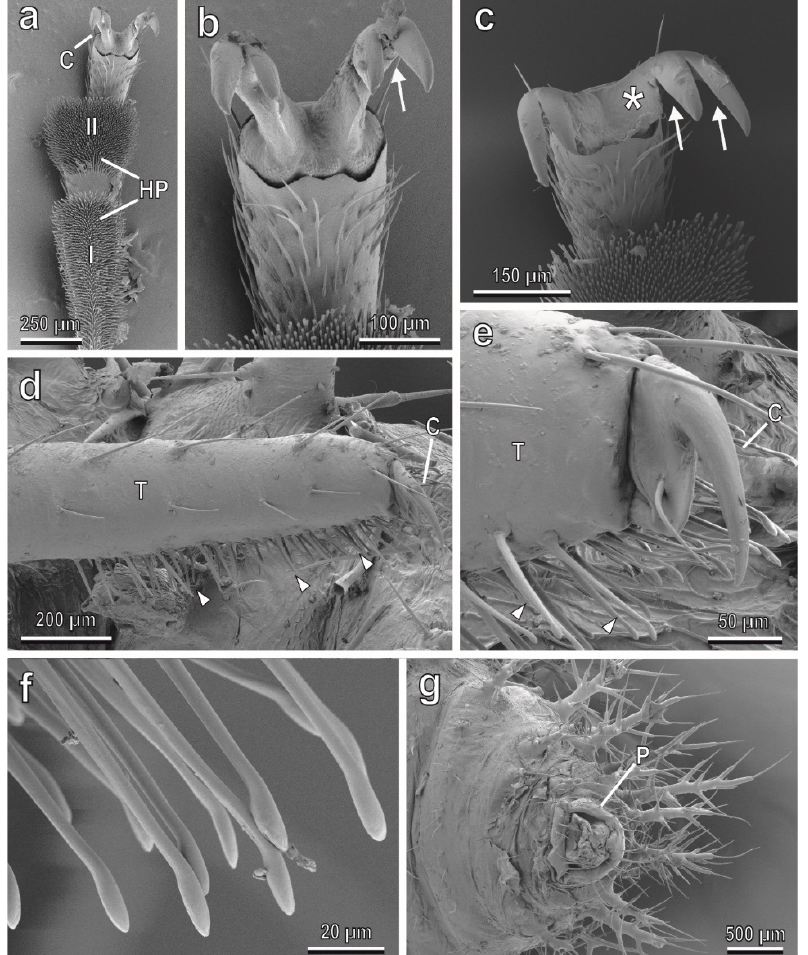
Figure 1. Tarsi of the female ( a – c ) and of the larva ( d – g ) of Chnootriba elaterii , cryo-SEM. ( a ) Hairy pads (HP) covered with numerous tenent setae located on the ventral side of the first (I) and second (II) tarsal segments. C, claws. ( b , c ) Details of the bifid claws with a basal tooth (asterisk). Note the deep clefts (arrows). ( d , e ) Single pretarsal claw (C) and tarsal tenent setae (arrowheads) located on the tarsus (T). ( f ) Distal portions of tenent setae. ( g ) Detail of the pygopodium (P) at the end of the